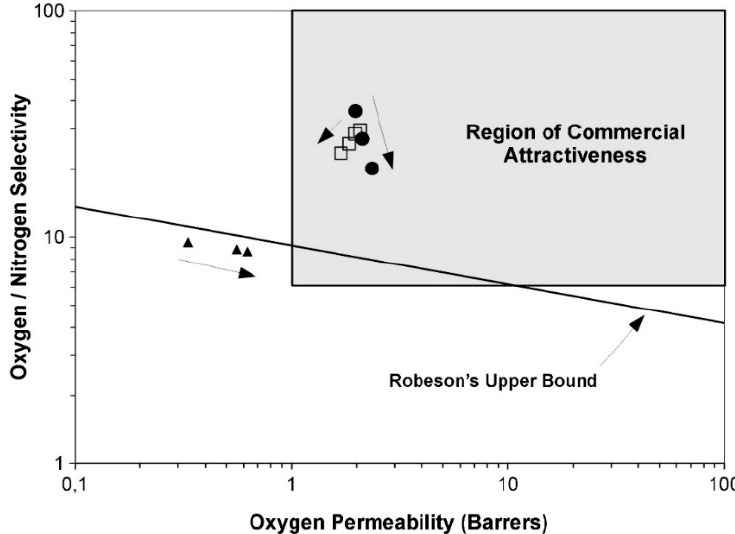
Figure 3. Performance of ideal Zeo TIPS membranes with an arrow indicating increasing polymer permeability ( • ), non-ideal Zeo TIPS membranes with an arrow indicating increasing β ( □ ), and dense mixed matrix membranes (MMM) with an arrow indicating increasing polymer permeability ( ▲ ), plotted with Robeson’s 1991 upper bound and region of commercial attractiveness [73]. All points correspond to 25 vol % zeolite loading and all Zeo TIPS membrane points correspond to a 3:1 ratio of void volume to polymer volume.